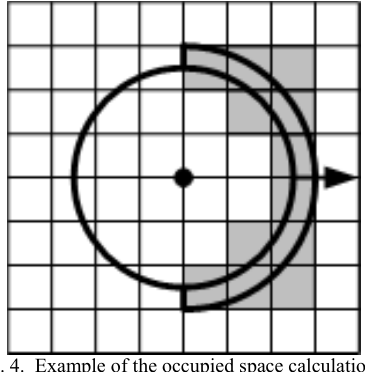
Fig. 4. Example of the occupied space calculation